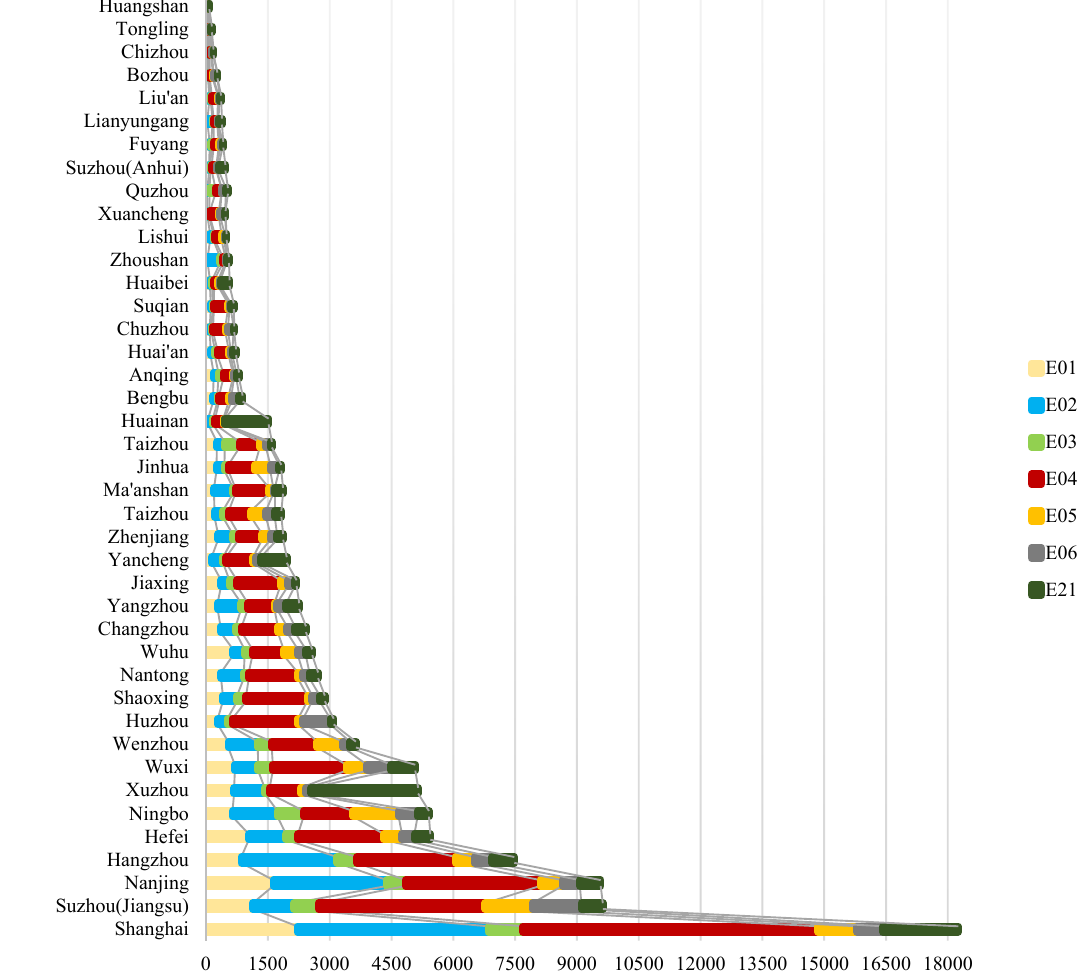
Figure 3. Composition of valid patents in the building construction industry across 41 YRD cities.